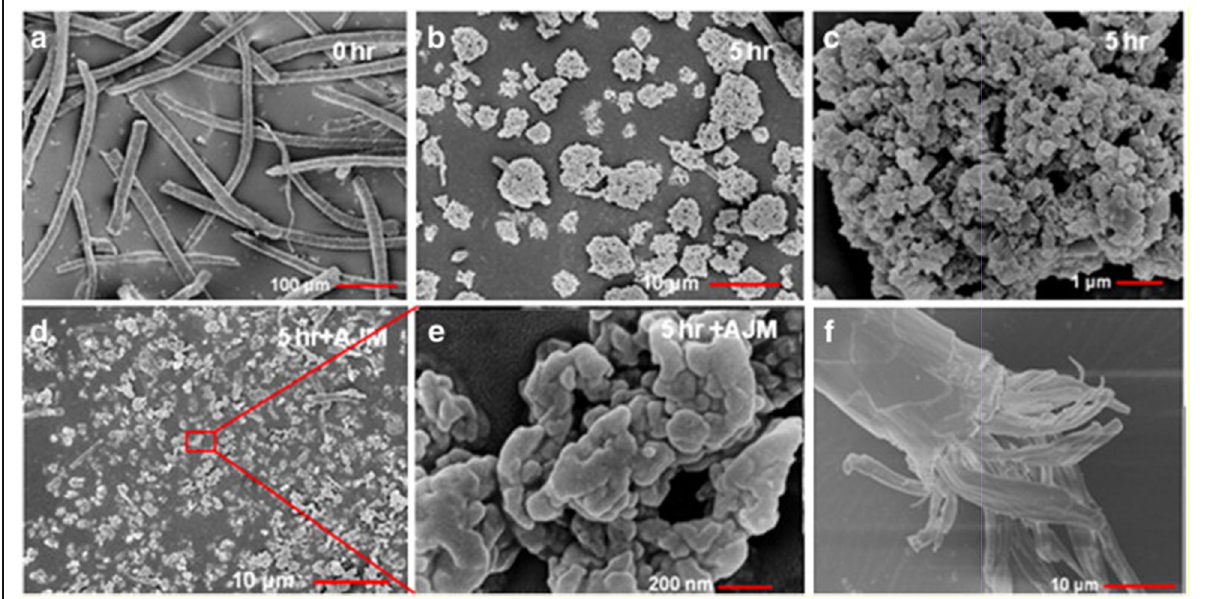
Fig. 2 SEM images of wool powder using combined wet milling and air-jet milling methods. a snippets; b after 5 h wet milling followed by drying; c magnified image of b ; d air jet milling of b ; e magnified image of d ; f fractured wool fiber. Reprinted with permission from